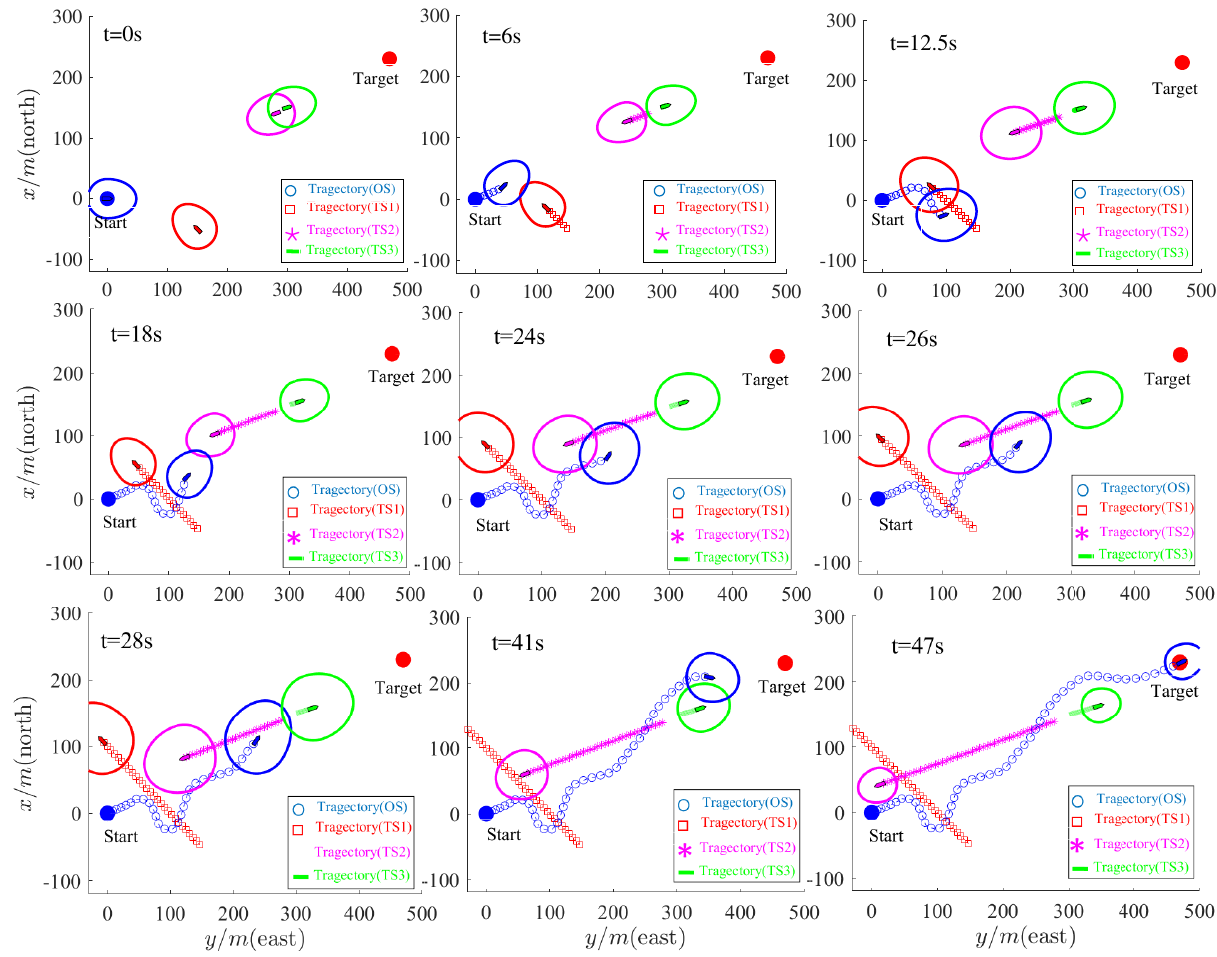
Figure 13. Simulation results of multiple obstacle avoidance. The comparison of the avoidance path trajectory using the SBG method and the proposed DNSD-based method is shown in Figure 15. The result indicates again that the length of the avoidance path under the proposed method was shorter than that under the SBG method, which validates the superiority of the proposed obstacle avoidance method for multiple dynamic